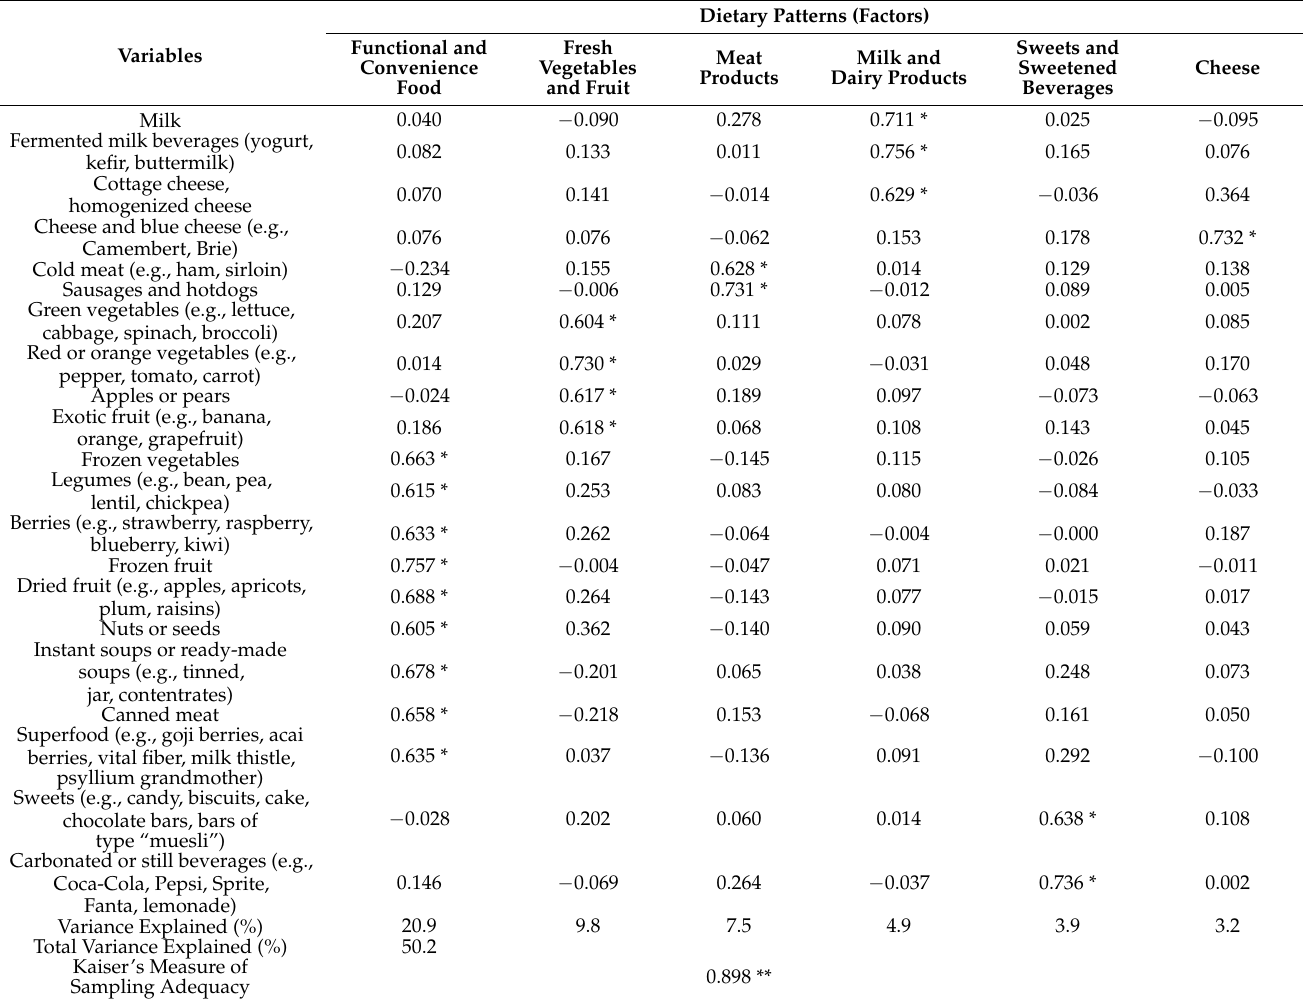
Table 2. Factor-loading matrix for the dietary patterns ( N =